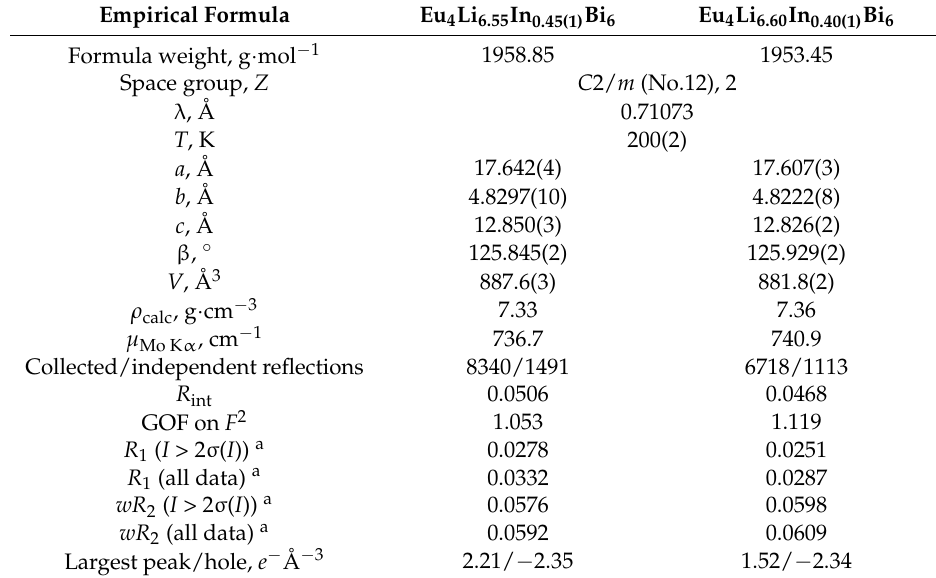
Table 3. Selected crystal structure data and refinement parameters for Eu 4 (Li 1 − x In x ) 7 Bi 6